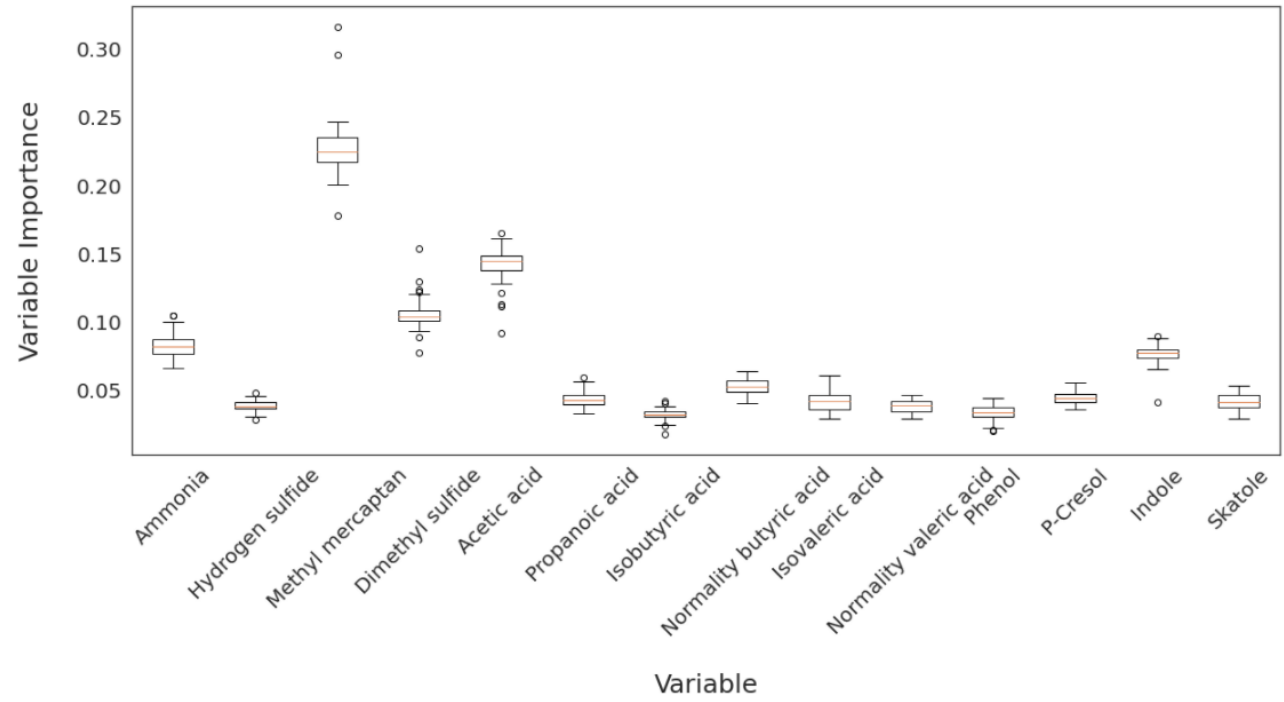
Figure 14. Boxplot of the variable importance about the best model in Table 3.